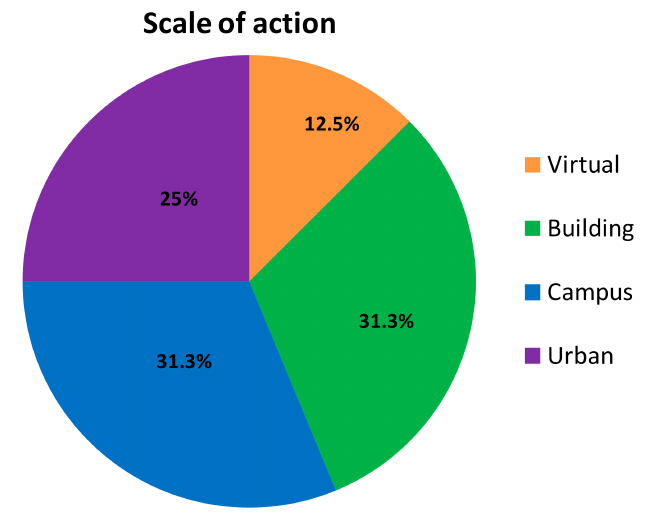
Figure 5. Distribution of the action scale defined for the laboratories